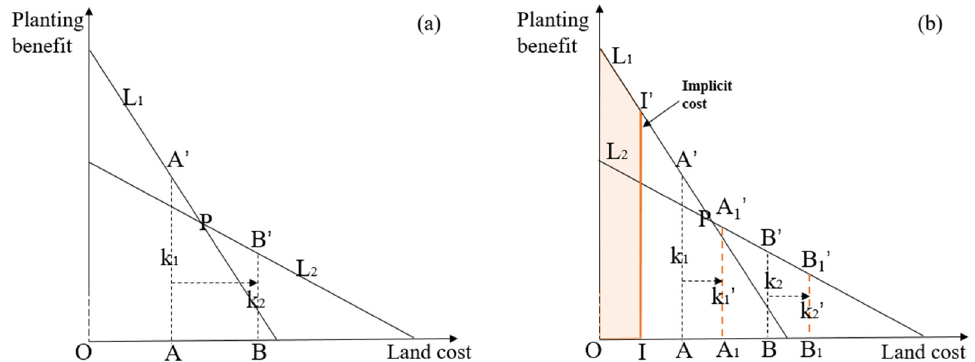
Figure 2. Land cost and crop selection in different situations. ( a ) The economic theory explanation of land cost on crop selection; ( b ) The economic theoretical explanation of land cost on crop choice after adding the implicit cost of land. The orange line represents the implicit cost of land.